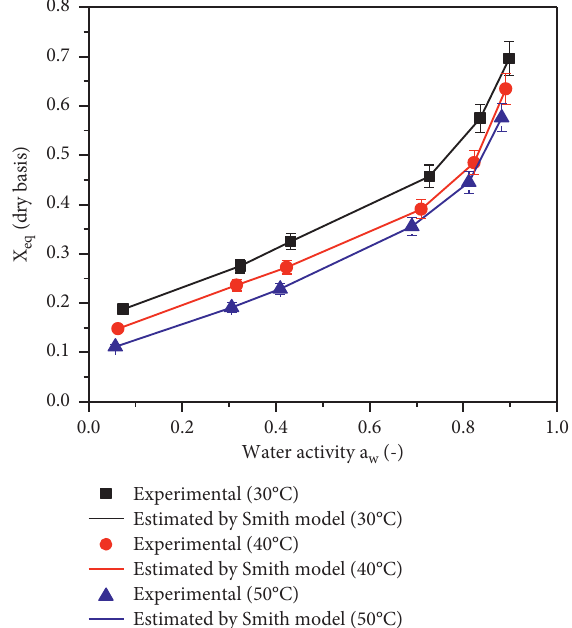
Figure 3: Adsorption isotherms of SCP at different temperatures.